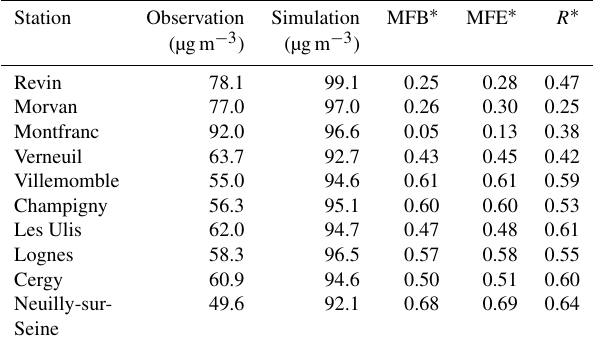
Table B1. Statistical indicators of the comparison of simulated hourly concentrations of O 3 to the concentrations measured at the background air monitoring stations within domain 2 (see Fig. 4).